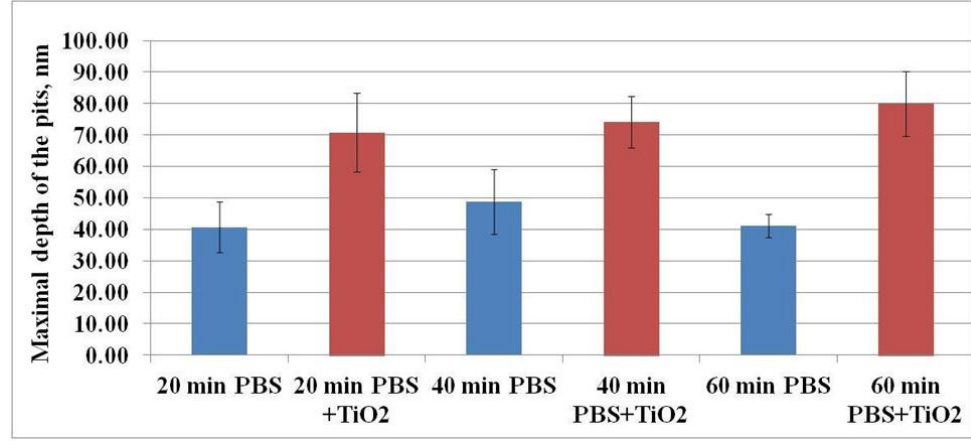
Figure 7. The dependence of the maximal depth of the pits on the exposure time of CHO cells to